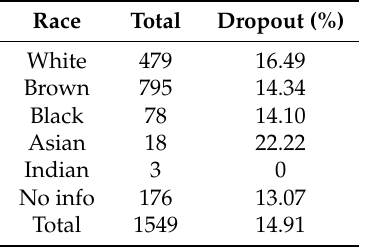
Table 3. Race and the corresponding number of observed samples and dropout percentage.